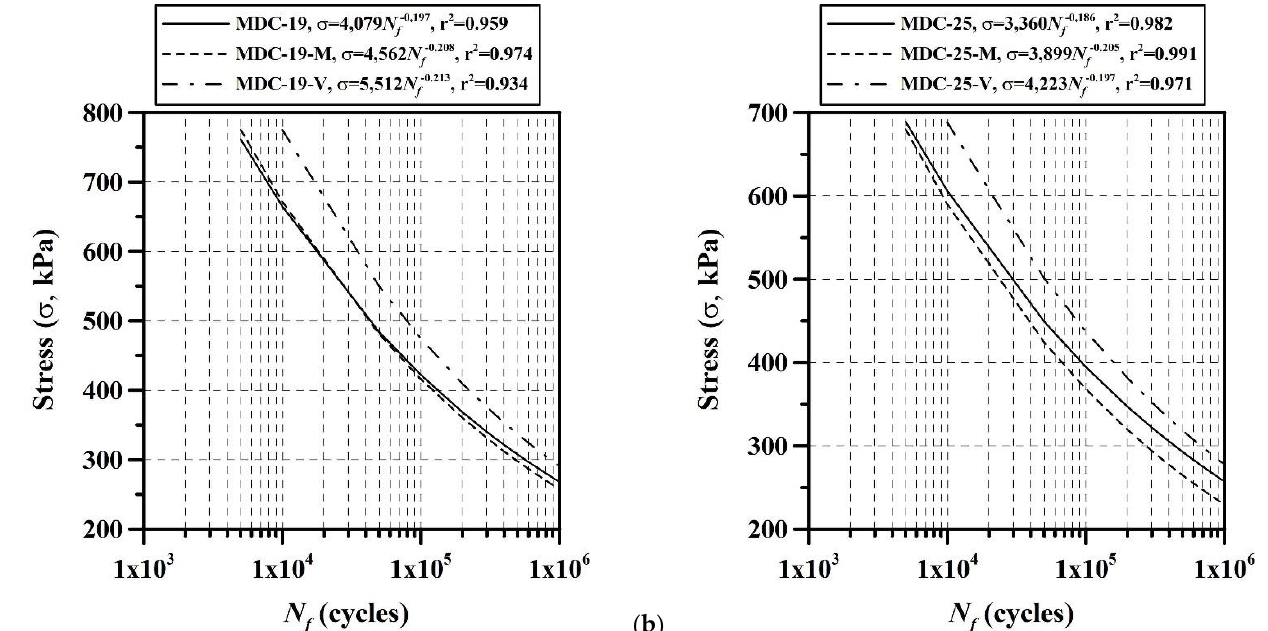
Figure 8. Fatigue curves: ( a ) MDC-19, MDC-19-M, and MDC-19-V; ( b ) MDC-25, MDC-25-M, and MDC-25-V.